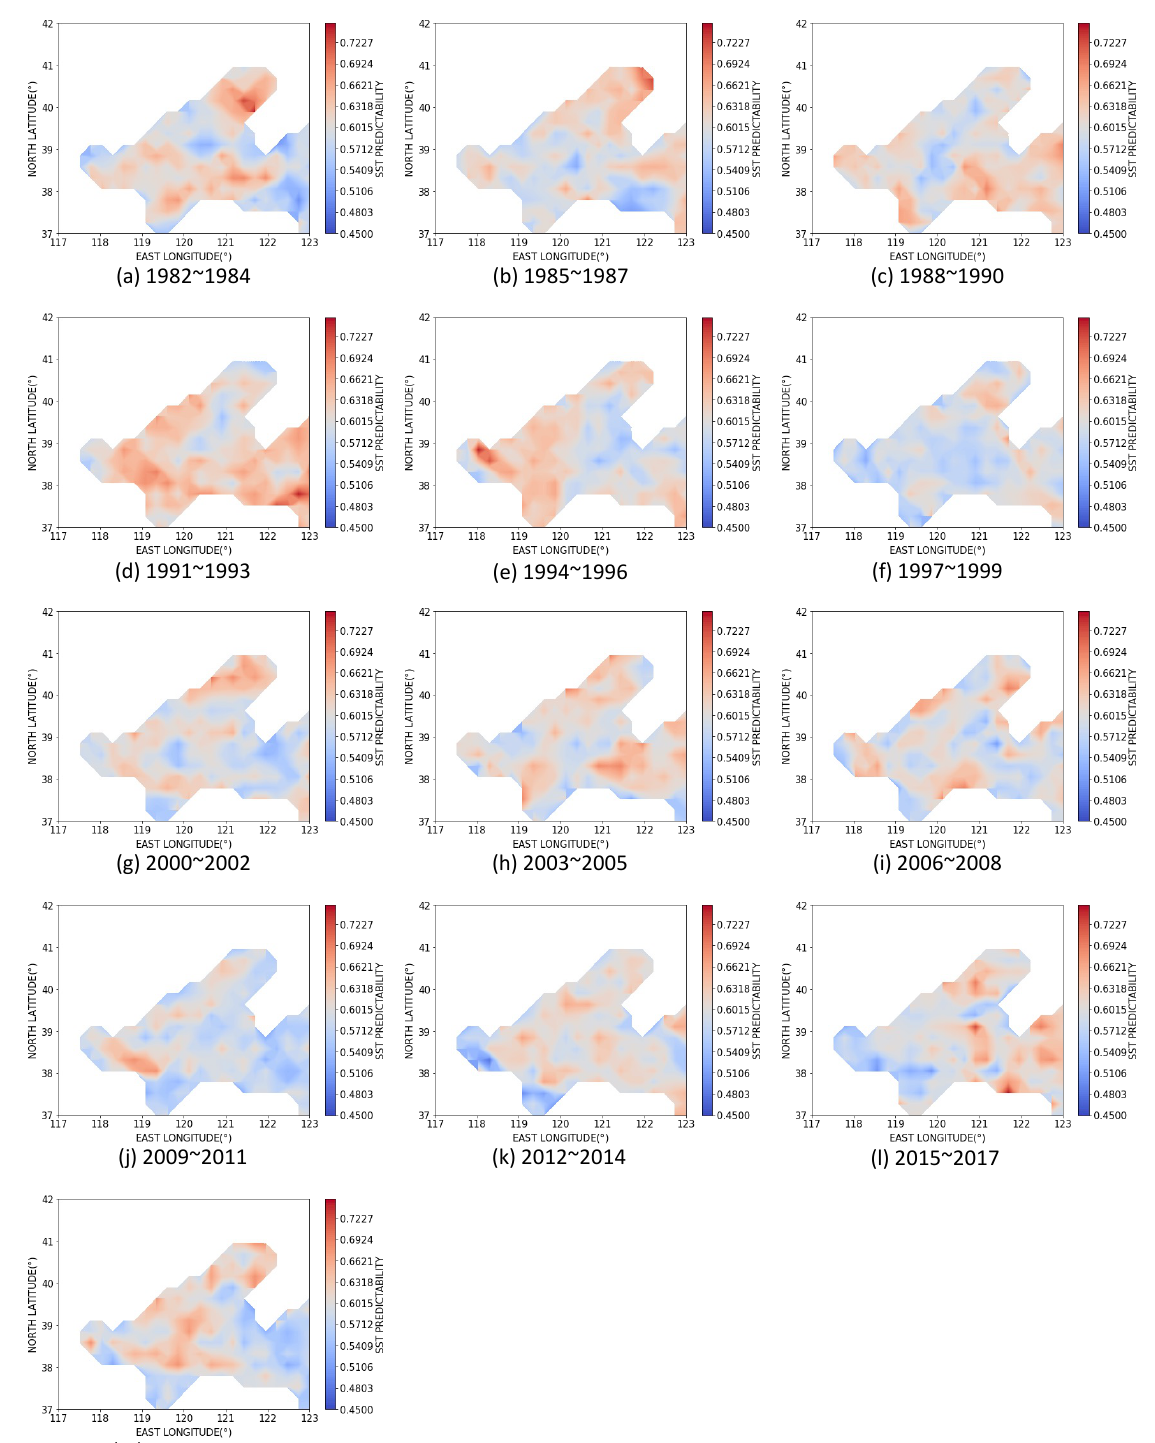
Figure 16. The predictability of SST in the Bohai Sea in 13 time periods from 1982 to